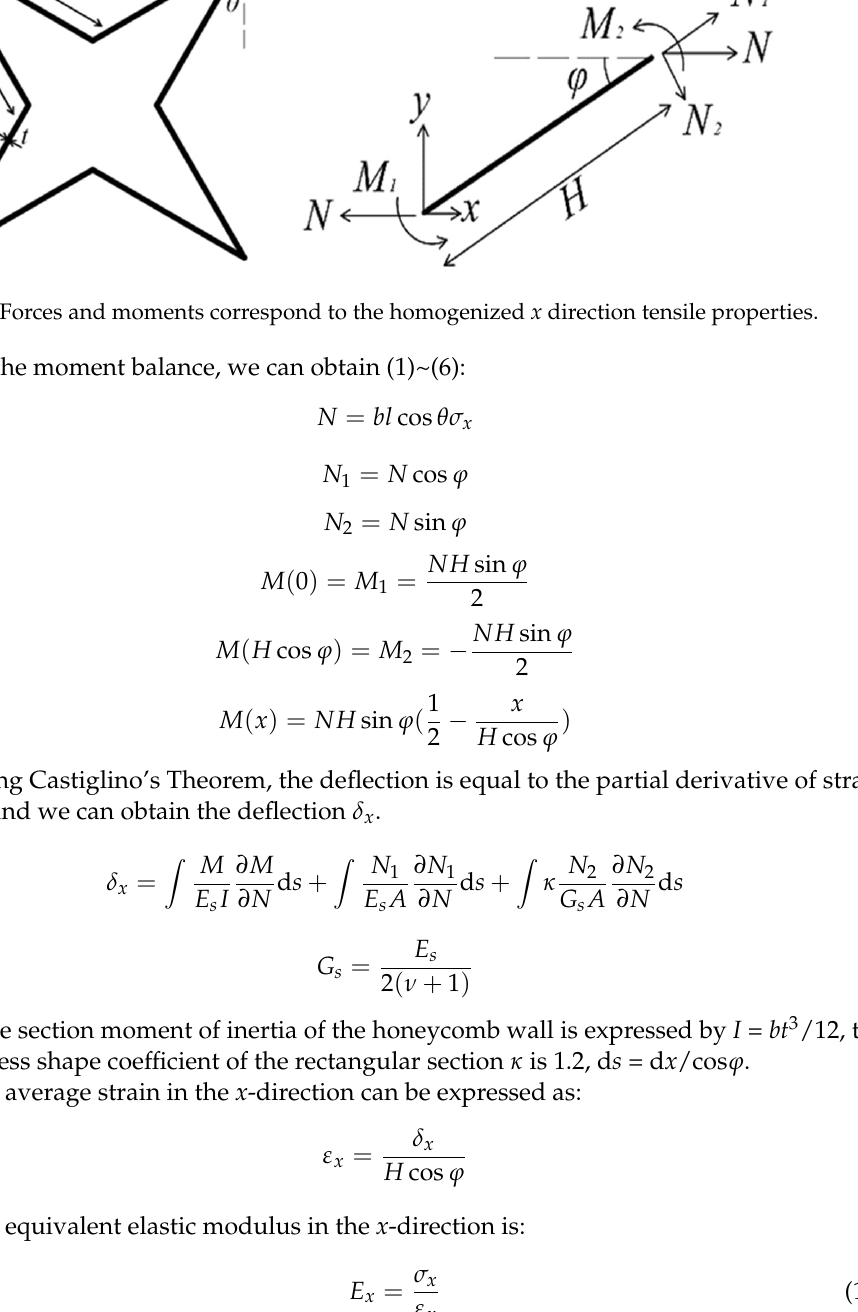
The nondimensional elastic modulus E x /E s in the x -direction is dimensionless, and the final result can be obtained as shown in the formula